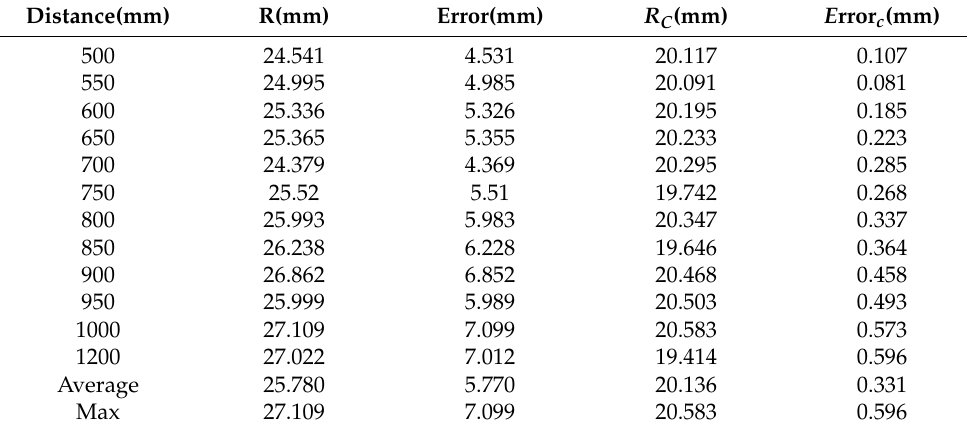
Table 4. Measurement result and error of standard